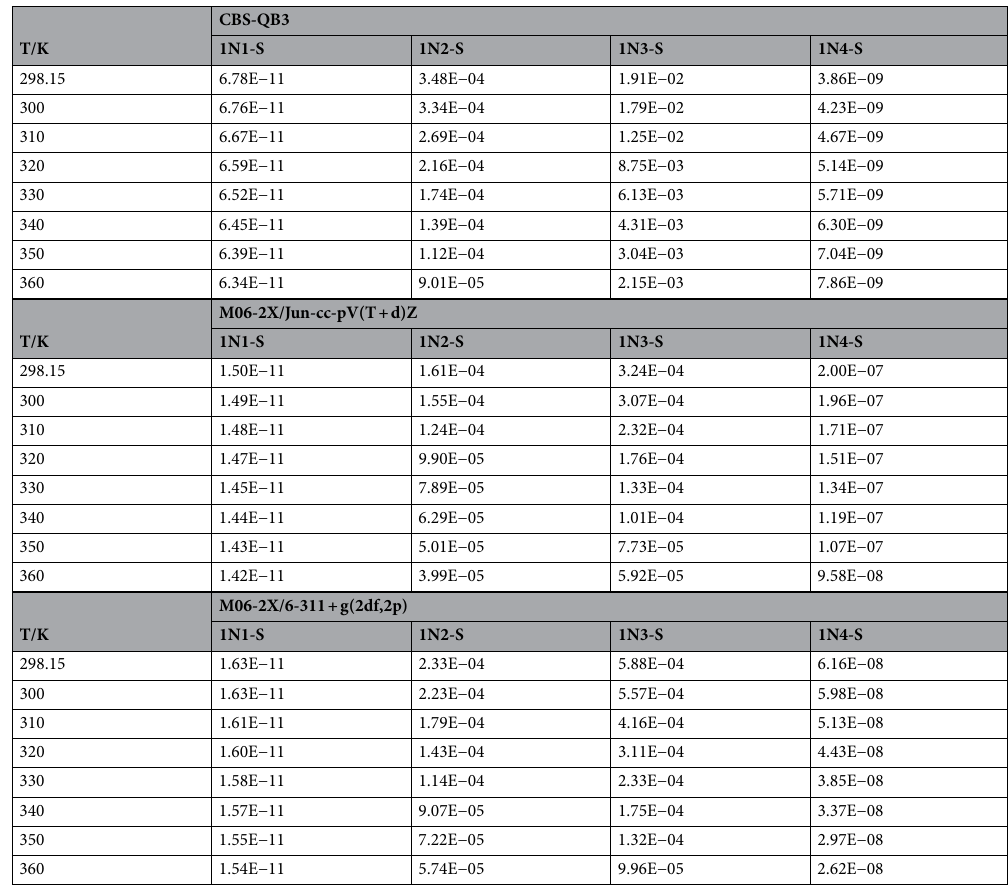
Table 9. Temperature dependent half-lifes (in s) of the predicted intermediates in 1,4-H shift of 3-hydroxythiophen-2(5H)-one at the CBS-QB3, M06-2X/Jun-cc-pV(T + d)Z, and M06-2X/6–311 + g(2df,2p)